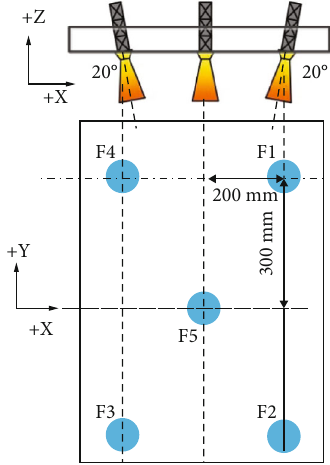
Figure 1: Diagram of propulsion system